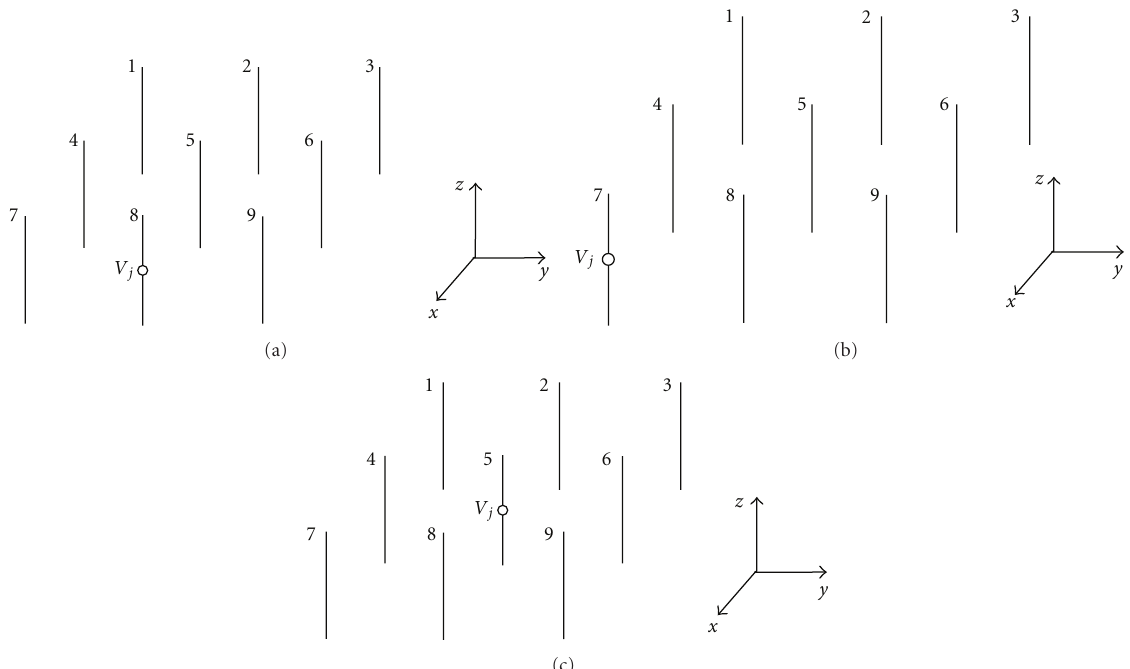
Figure 5: Required calculations for the open-circuit voltage method based on symmetry considerations. In (a), induced terminal currents by the excitation of element 8 using a voltage source are used for those by the excitation of elements 2, 4, and 6. In (b), induced terminal currents by the excitation of element 7 are used for those by the excitation of elements 1, 3, and 9. Finally in (c), induced terminal currents by the excitation of element 5 are only used for this element since no other element has the same surrounding electromagnetic